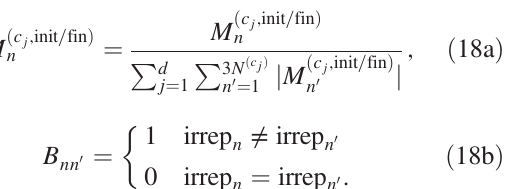
FIG. 3. (a) Overlap of the candidate and the final SDFT result. The overlap is defined in Eq. (12). The color scale indicates the variance of the irreducible representation. Inset: the variance of the irreducible representation for the lowermost bin (see arrow). (b) The maximum overlap of the experiment and the initial candidate with respect to the CMP basis. (c) The maximum overlap of the experiment and the initial candidate with respect to all candidates including the CMP basis and additional guesses. The color classifies if the magnetic space group (MSPG) agrees with the experimentally determined